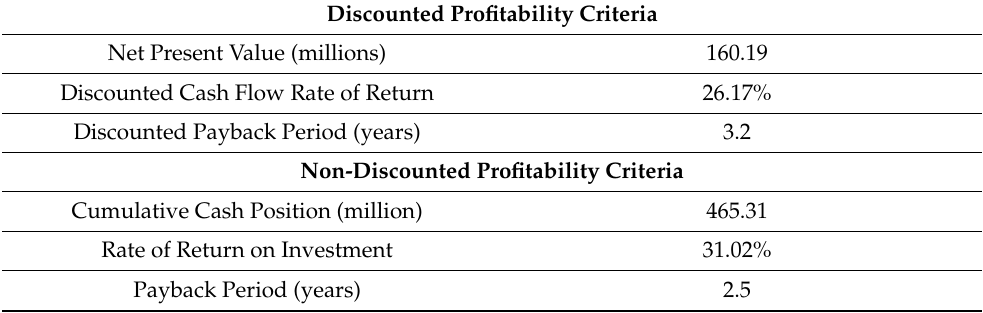
Table 10. Profitability criteria for